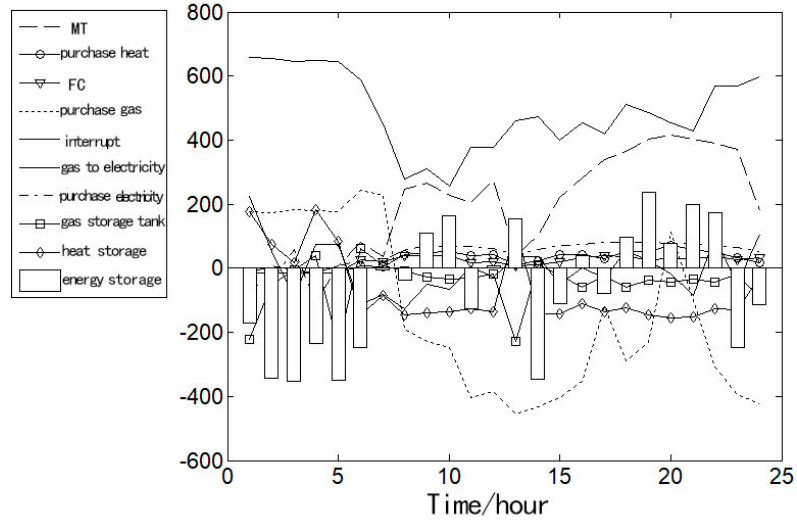
Figure 4. Optimizing economic dispatch scheme for integrated energy system in scenario 2.